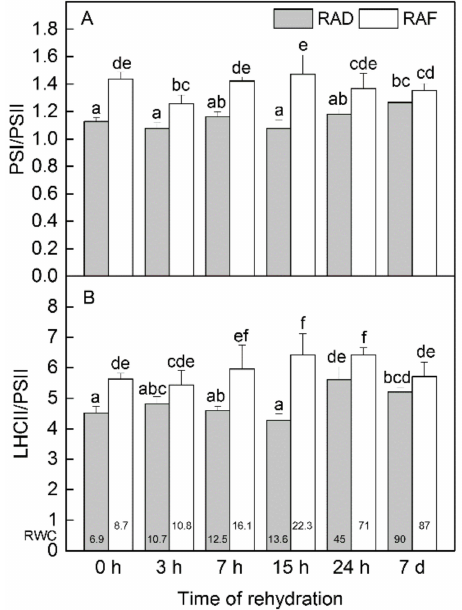
Figure 5. Changes in the ratios of the main thylakoid complexes PSI/PSII ( A ) and LHCII/PSII ( B ) in H. rhodopensis during recovery from drought—(RAD) and freezing-induced desiccation (RAF) as a function of the time of rehydration. Thylakoids (500 µ g chlorophyll mL − 1 ) were solubilised using 1% ( w / V ) β -DM plus 1% ( w / V ) digitonin, and complexes were separated in 4.3–12% Blue Native gel gradients. PS—photosystem; LHCII—light-harvesting complex II. The ratios were calculated